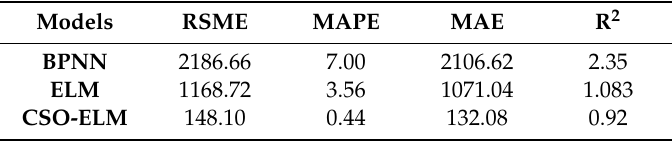
Table 5. Calculation results of error